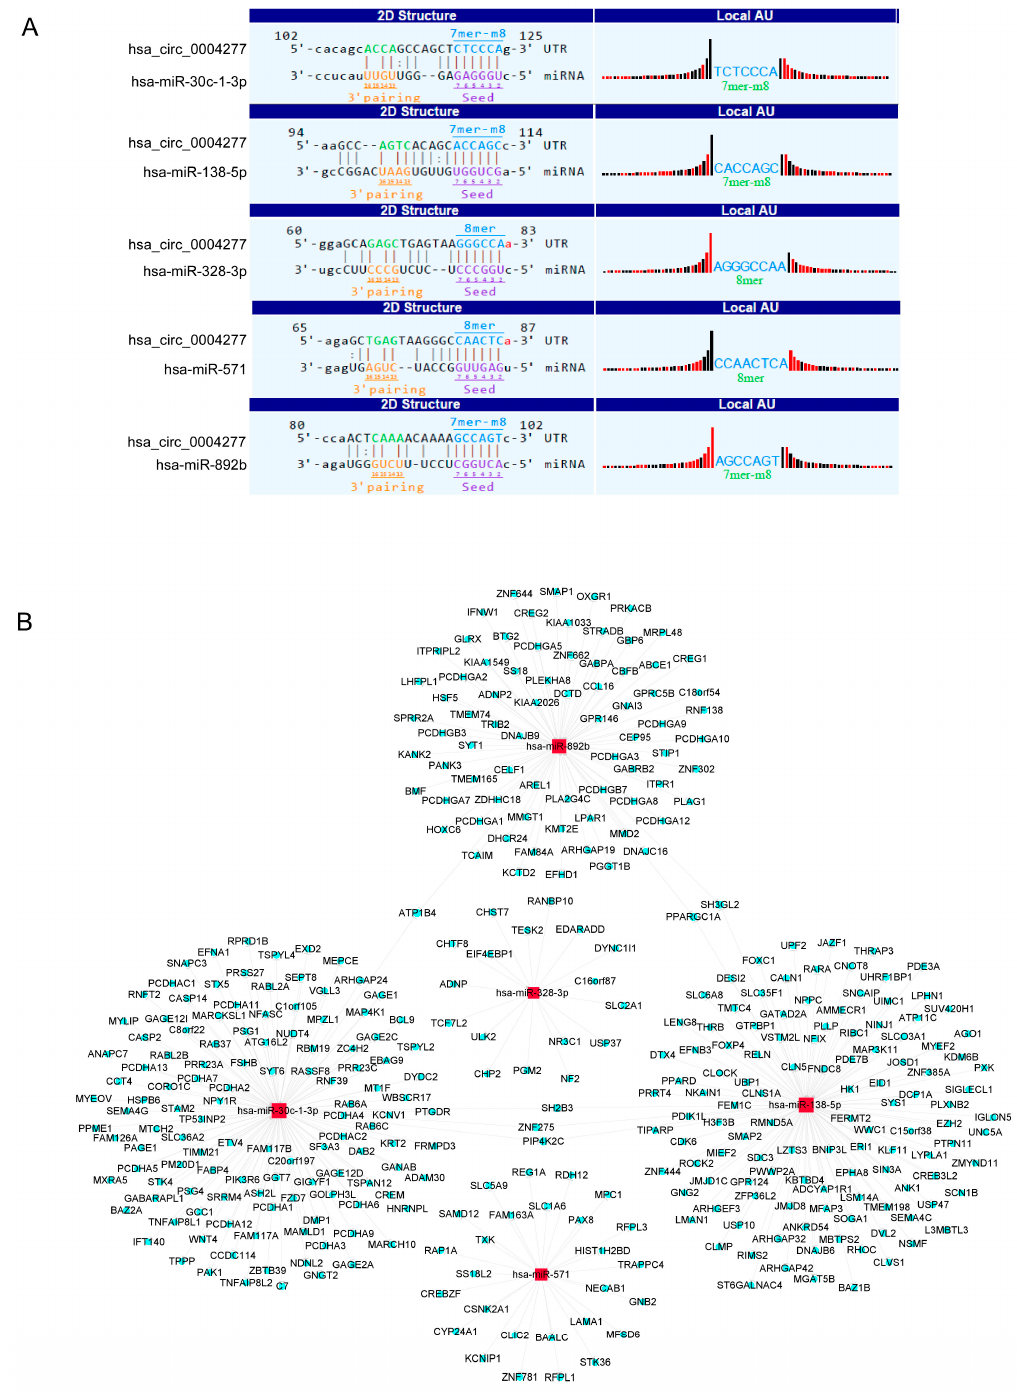
Figure 4. Bioinformatics prediction of hsa_circ_0004277 in AML. ( A ) The five highest-ranking candidate miRNAs matched hsa_circ_0004277; ( B ) circRNA-miRNA-mRNA network of hsa_circ_0004277, focused on the five highest-ranking candidate